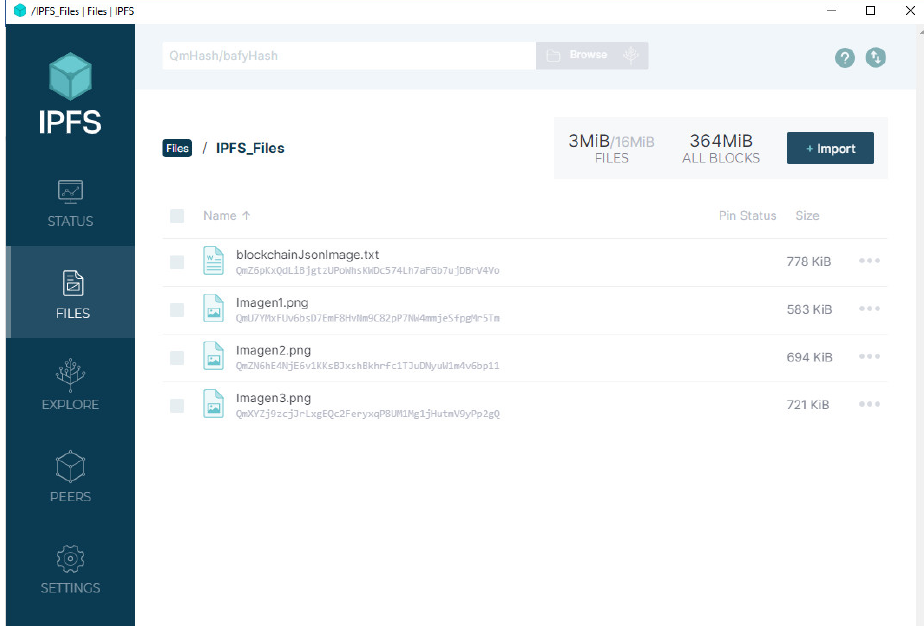
Figure 14. Appearance of the dashboard in the IPFS node